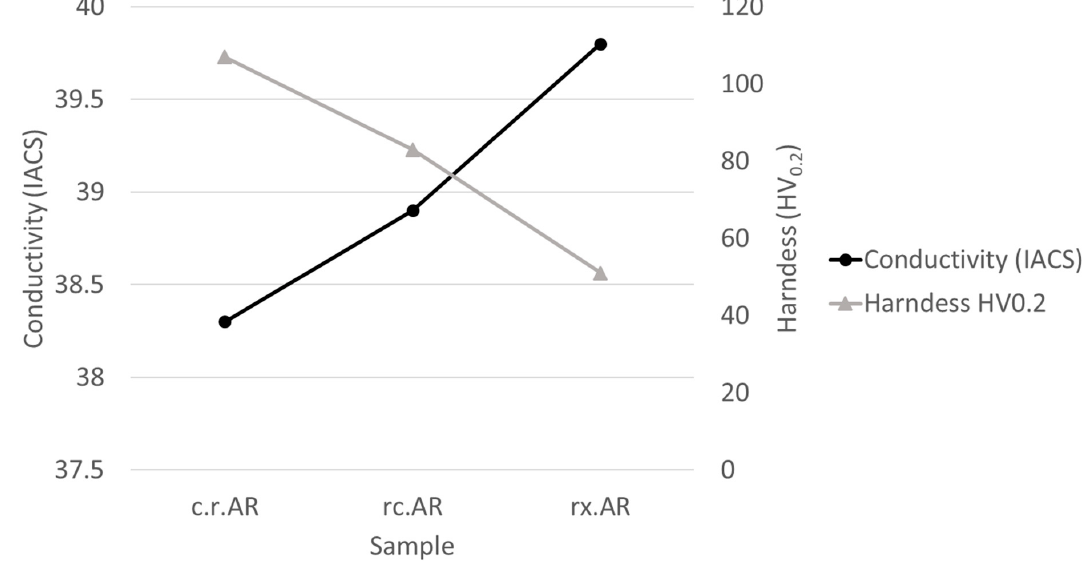
Metals 2021 , 11 , x FOR PEER REVIEW Figure 3. Conductivity vs. Hardness diagram of the three states examined (cold ‐ rolled, recovered, and recrystallized). Figure 3. Conductivity vs. Hardness diagram of the three states examined (cold-rolled, recovered, and recrystallized).